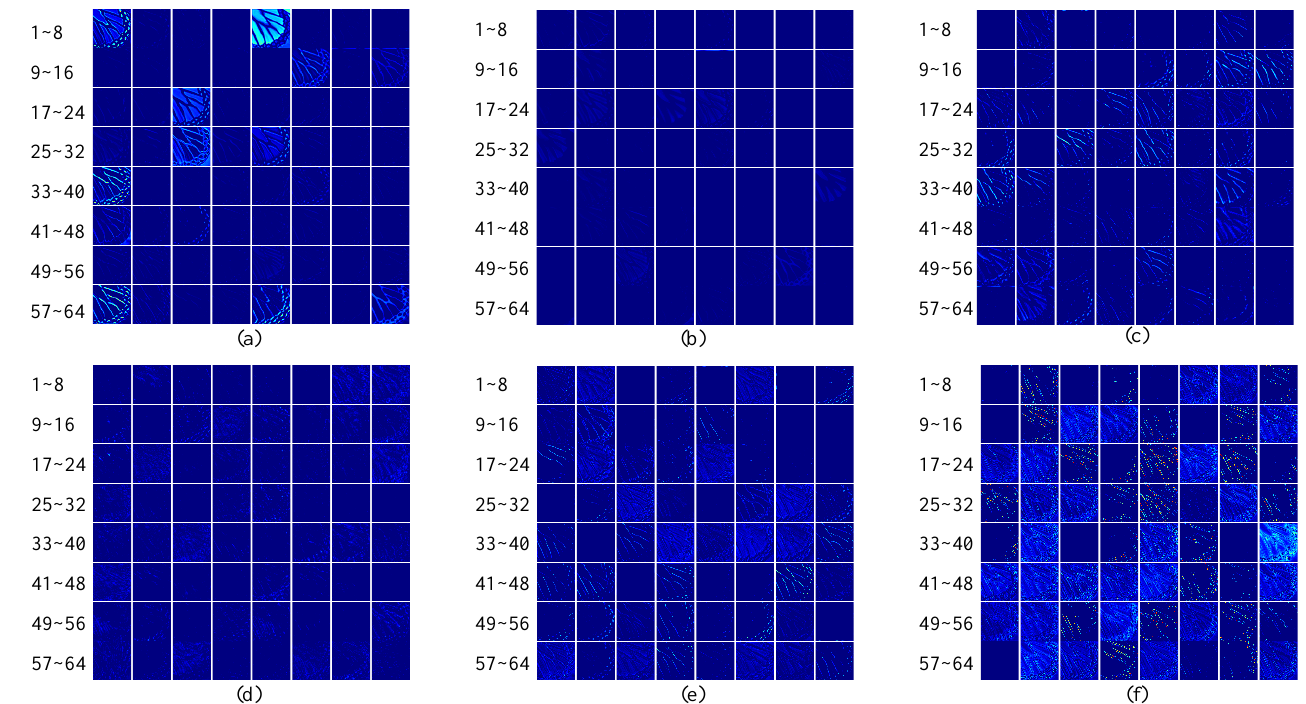
Figure 2. Visualization of the feature maps in RCAN. ( a , b ), respectively, represent the feature map in the first and last blocks in the first residual group. ( c , d ) represent the feature map in the first and last blocks in the fifth residual group. ( e , f ) represent the feature map in the first and last blocks in the last residual group.